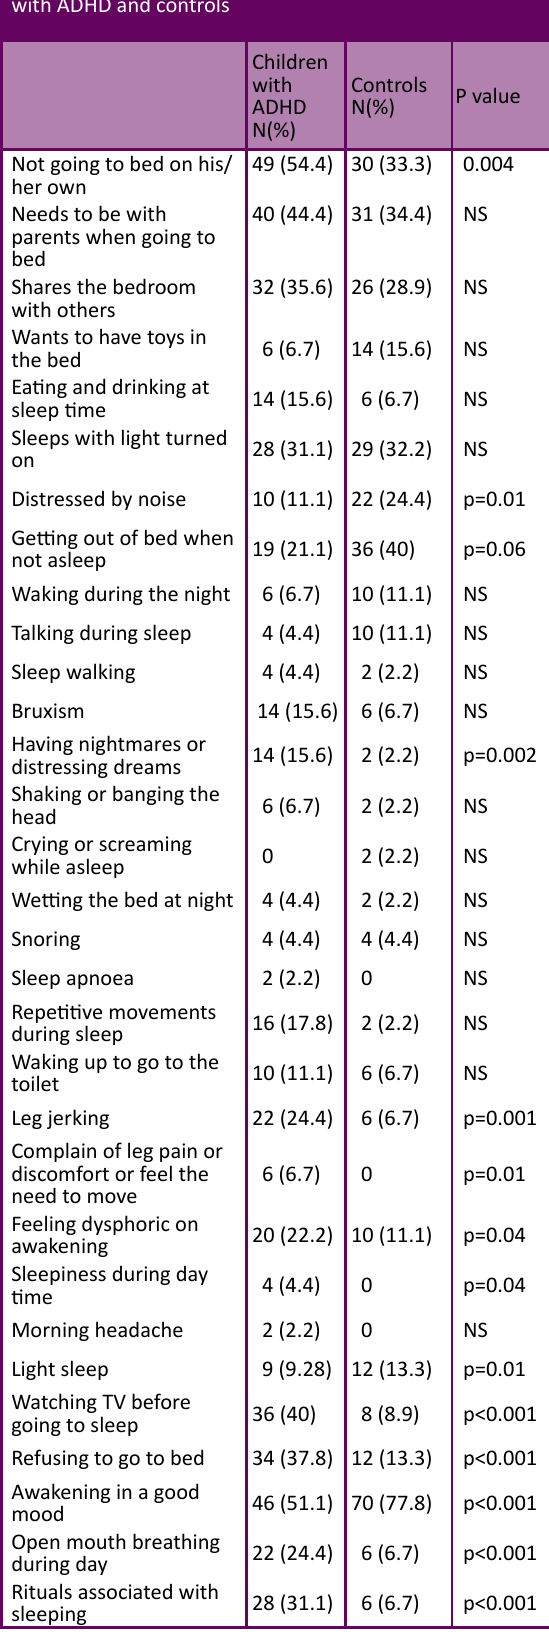
Table 1 – Sleep related behaviours in children with ADHD and controls